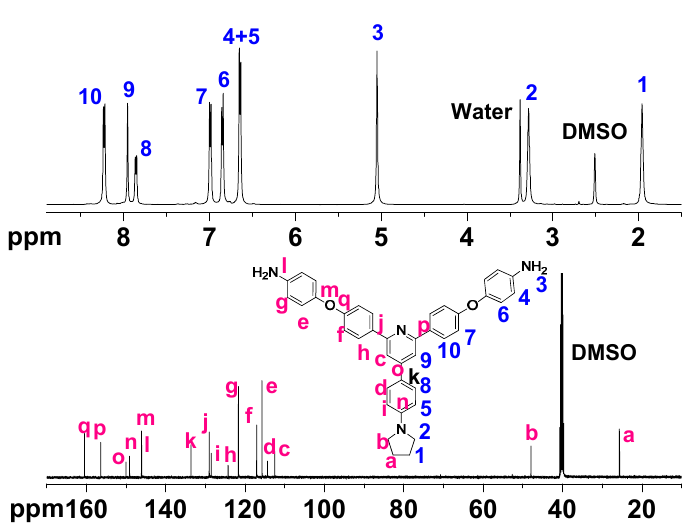
Figure 1. 1 H ( up ) and 13 C NMR ( down ) spectra of PPAPP.